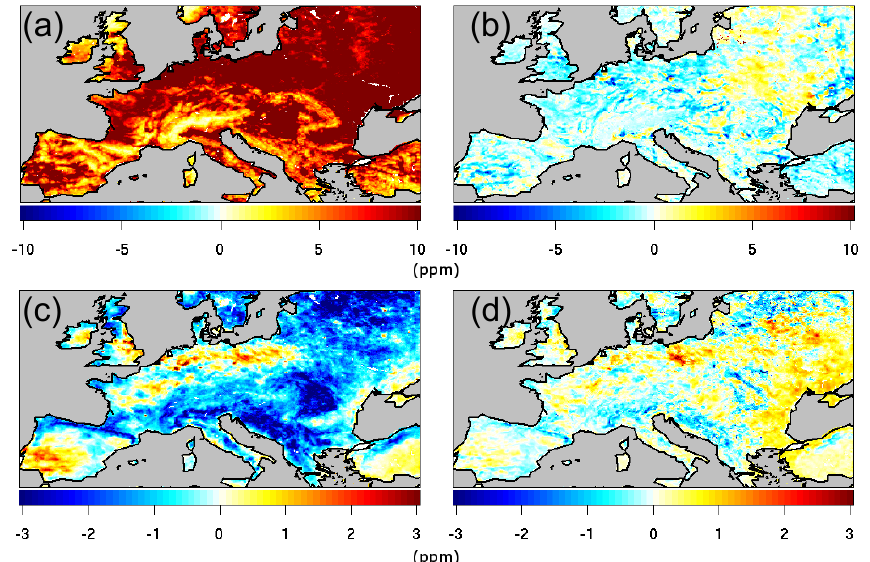
Fig. 11. Monthly mean ML CO 2 difference ( C m , myj − C m , ysu ) for each land grid cell at 01:00 (a) and 12:00UTC (c) . The bias after applying the offline reshuffling method (Eq. 1) to the MYJ mixing ratios is shown for 01:00 (b) and 12:00UTC (d)